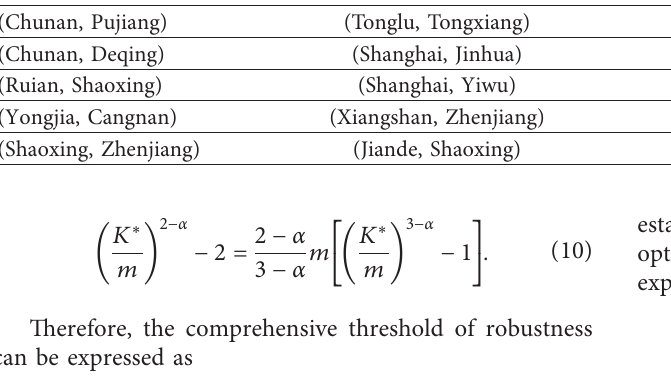
Table 3: Regional logistics network optimization